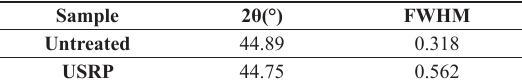
Table 5. Full width at half peak (FWHM) values of (110) diffraction peaks of GCr15 steel. Sample